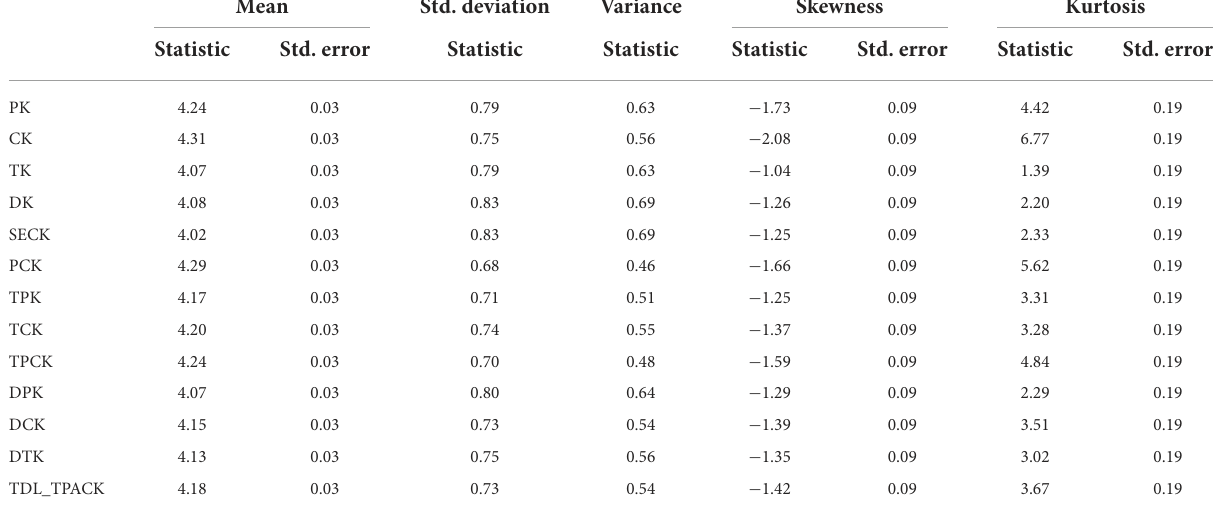
TABLE 5 Demographic statistics for